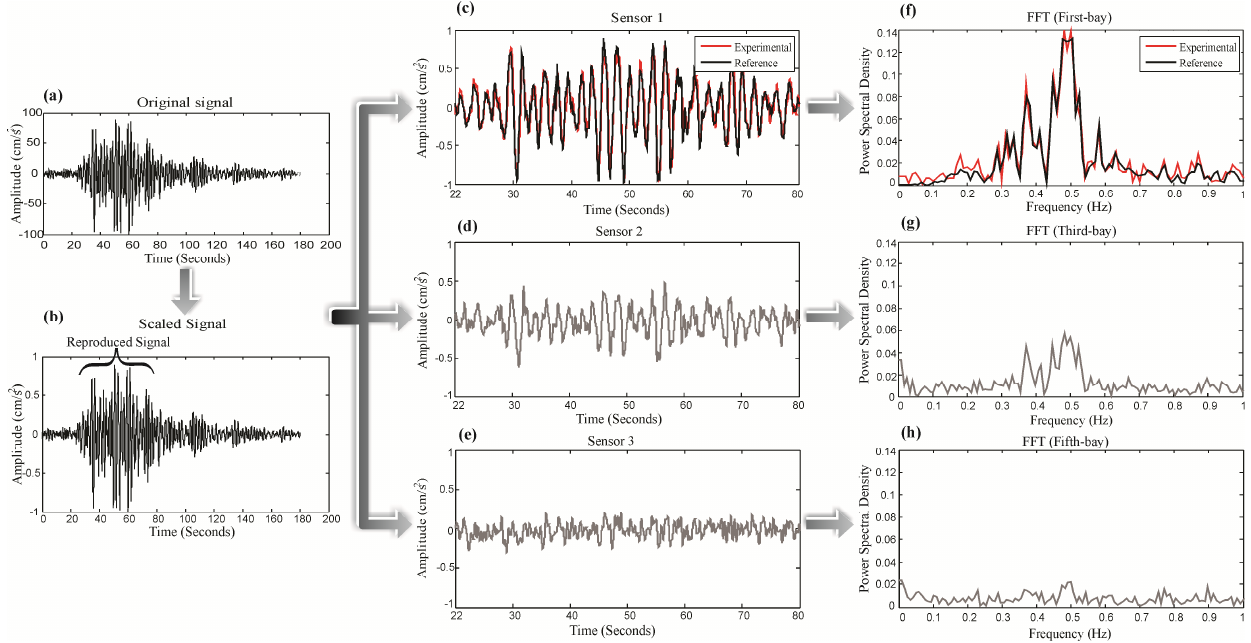
Figure 8. Earthquake in México 1985. 2 Fig. 8. Earthquake in M´exico